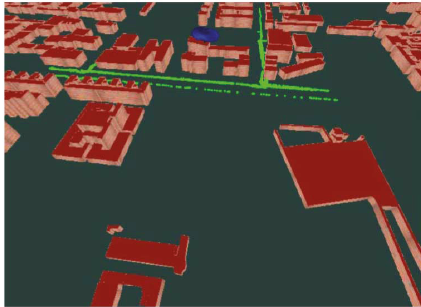
Figure 14: Localization of the receiver points with LOS and NLOS (green spheres) and the transmitter (blue).